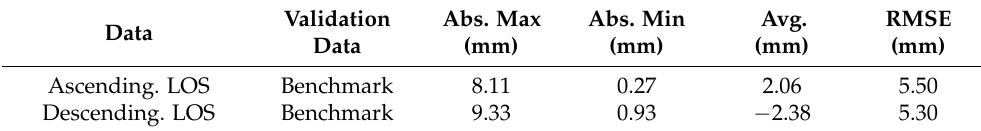
Table 4. Statistics for validating the PS-InSAR results.